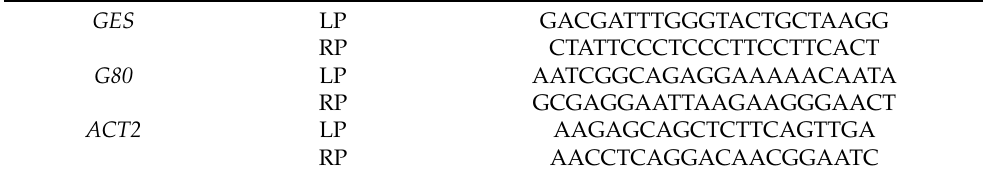
Table 1. qRT-PCR Primer list.